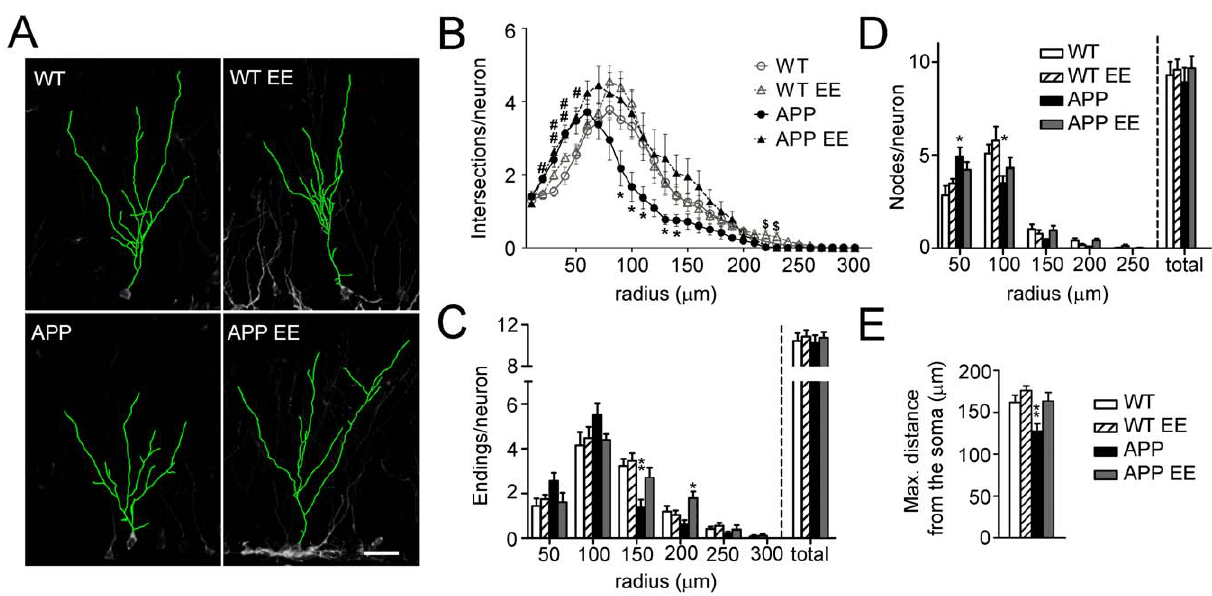
Figure 4. Normal morphology of doublecortin-positive neurons after environmental enrichment in APP Sw,Ind mice. (A) Three dimensional reconstructions of doublecortin (Dcx) stained cells (green) in the DG region of the hippocampus of the different experimental groups. Scale bar =30 m m. (B) At least eight EF type Dcx-cells per mouse (n=6 mice/group) were reconstructed using confocal images and the number of intersections of dendrites with concentrical circles at increasing radius (10 m m) were quantified. Reduced number of intersections from radius 90–140 in APP Sw,Ind mice was efficiently reverted by environmental enrichment (EE). (C) Number of dendritic endings into the area delimited by concentric circles at increasing radius (50 m m). Decreased number of neuronal dendritic endings at 150 m m from the soma in APP Sw,Ind mice is reversed by EE. (D) The number of nodes, which is significantly increased at 50 m m and reduced at 100 m m from the soma in APP Sw,Ind mice, is normalized by enrichment. (E). The maximum distance reached by the dendritic tree of Dcx + cells into the molecular layer of the DG was significantly reduced in APP Sw,Ind mice and reversed by EE. Data represent mean 6 SEM. In B: # p , 0.05 and ## p , 0.01, compared to WT and WT EE mice; *p , 0.05, compared to the rest of groups; $ p , 0.05, WT EE mice versus the other groups. In C, D and E: *p , 0.05 and **p , 0.01, APP Sw,Ind mice or APP Sw,Ind EE mice versus the other groups. Number of cells/mouse: $ 8; Number of mice/group: 6.